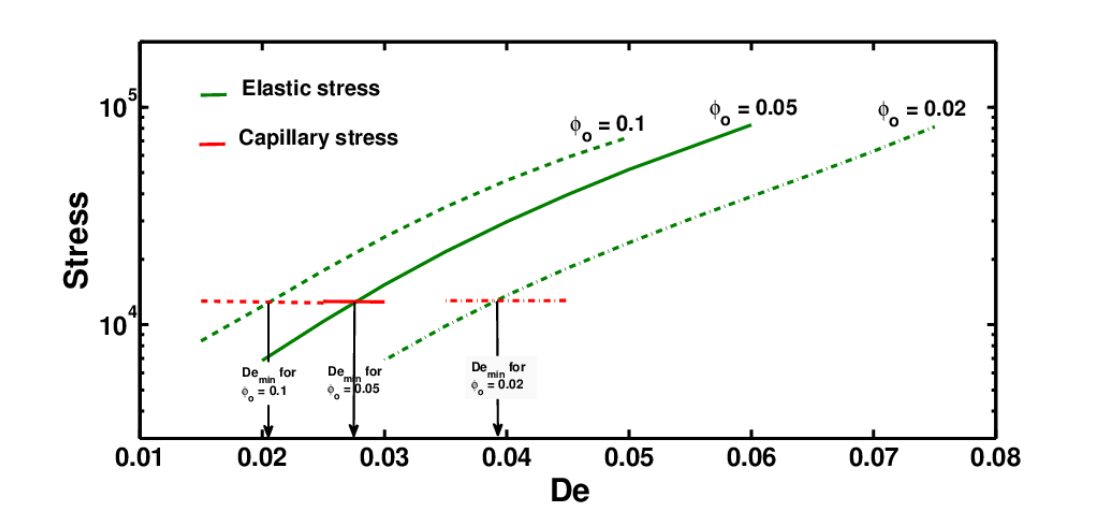
Figure 5. Elastic and capillary stresses at z = z max as a function of De for polymer solutions with different initial concentrations.